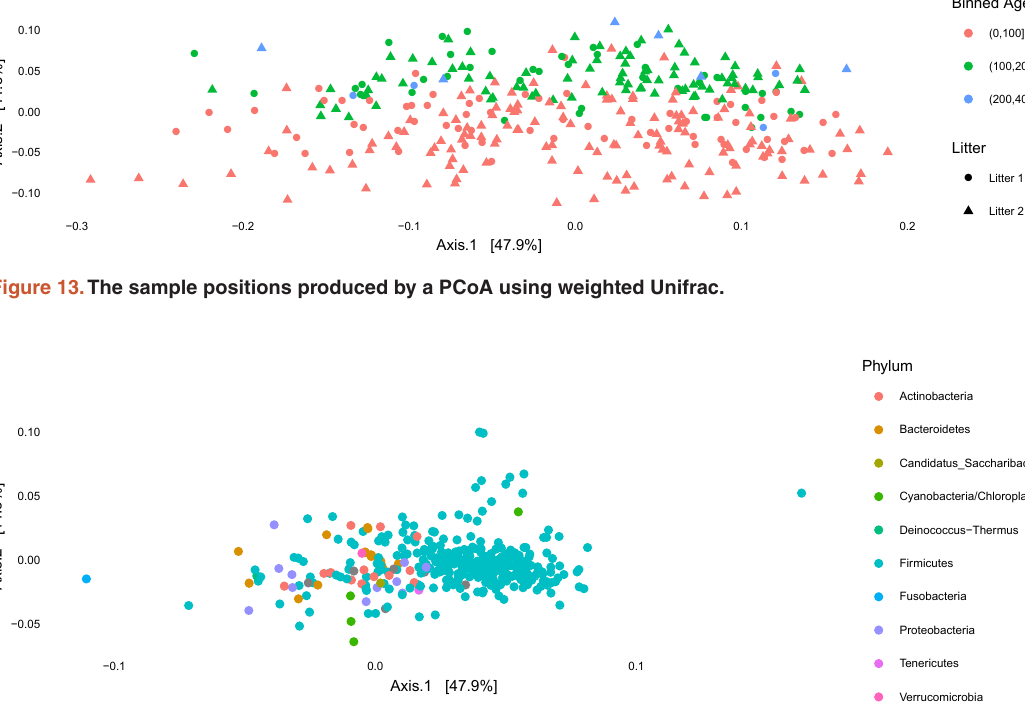
Figure 14. Species coordinates that can be used to interpret the sample positions from PCoA with weighted Unifrac. Compared to the representation in Figure 12, this display is harder to interpret.